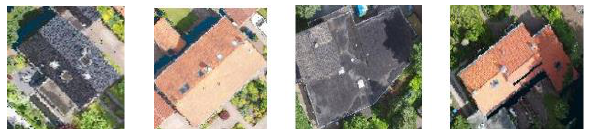
Figure 10. UAV and ALS point clouds; Grey1; Red1; Grey2; Red2 respectively